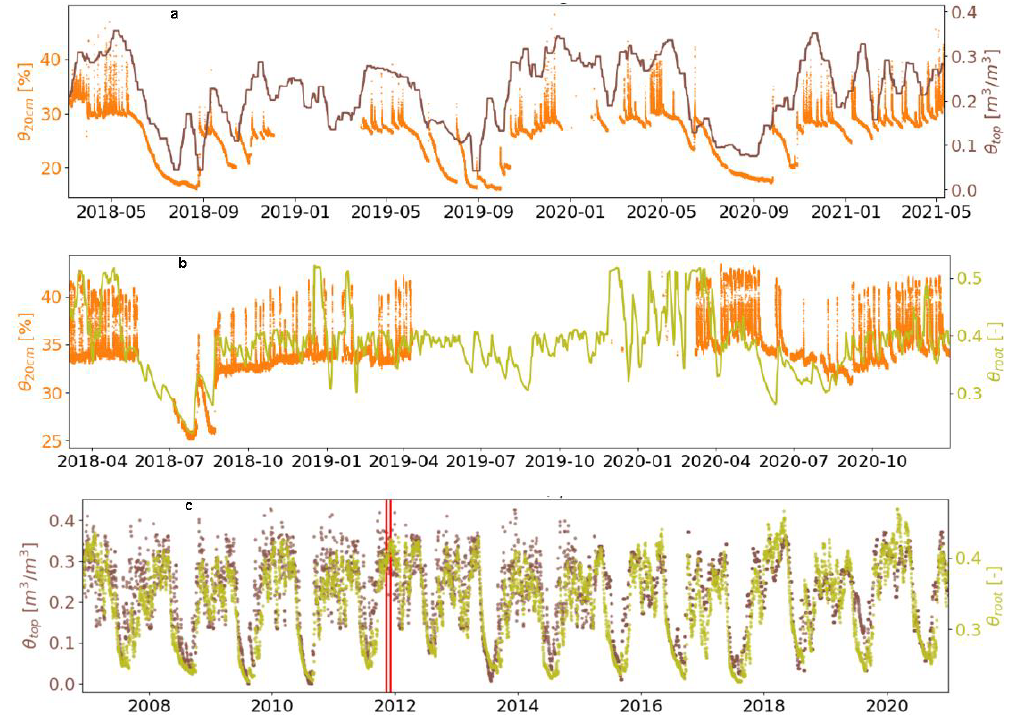
Figure A1. Selected examples of satellite- and model-derived soil moisture compared to in situ recorded soil moisture at 20cm soil depth (AWS): (a) θ top and in situ θ 20cm soil moisture time series at Gacurabwenge station; (b) model-derived soil moisture in the root zone θ root and in situ soil moisture θ 20cm at Kibisabo station; (c) satellite-derived θ top and model-derived soil moisture in the root zone θ root , with vertical red lines indicating the timing of the landslide occurrence